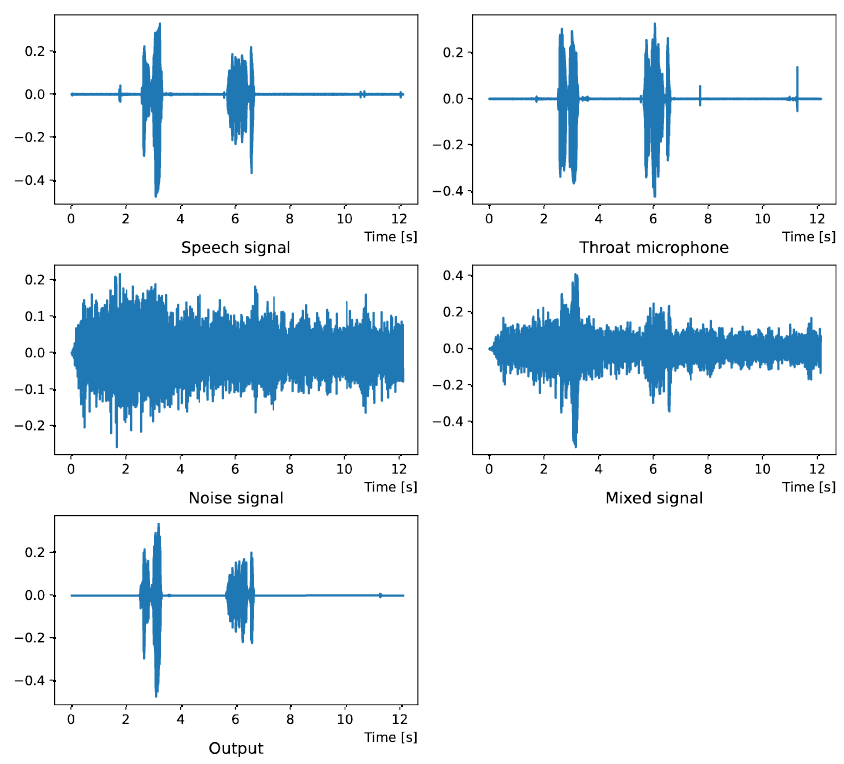
Figure 2. Waveform (Intersection noise).